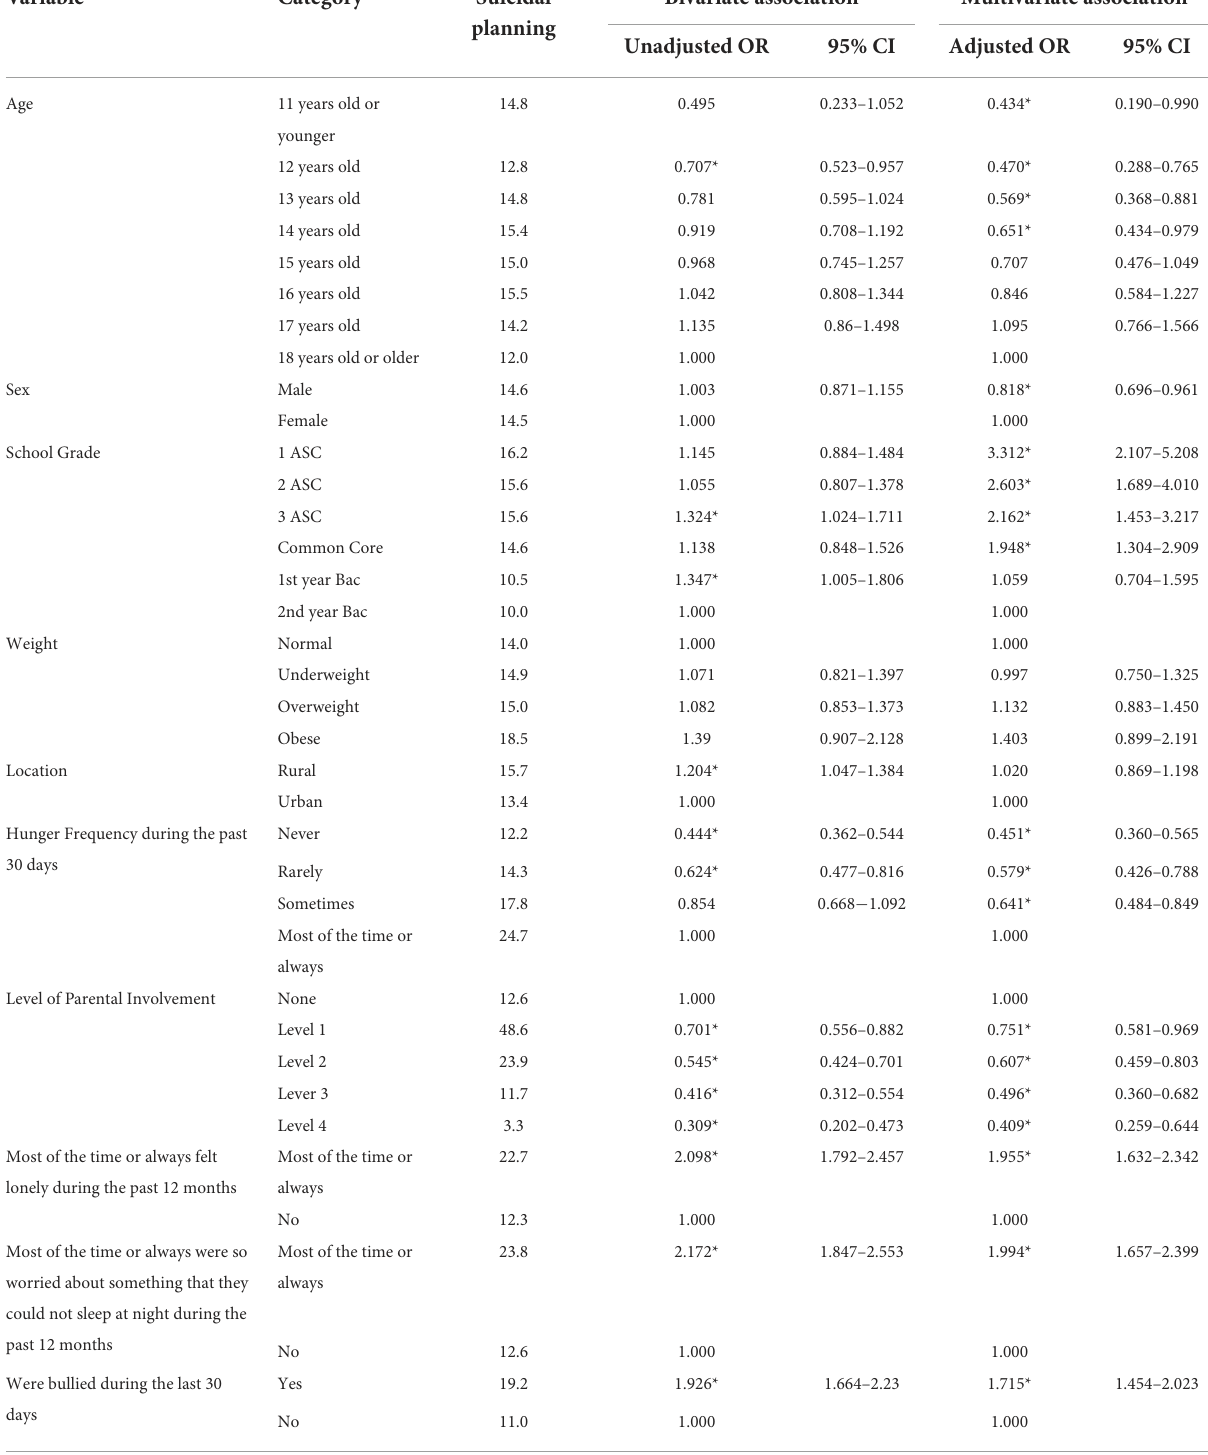
TABLE 4 Chi-squared and regression analysis of demographics and risk factors associated with suicidal planning. Variable Category Suicidal Bivariate association Multivariate planning